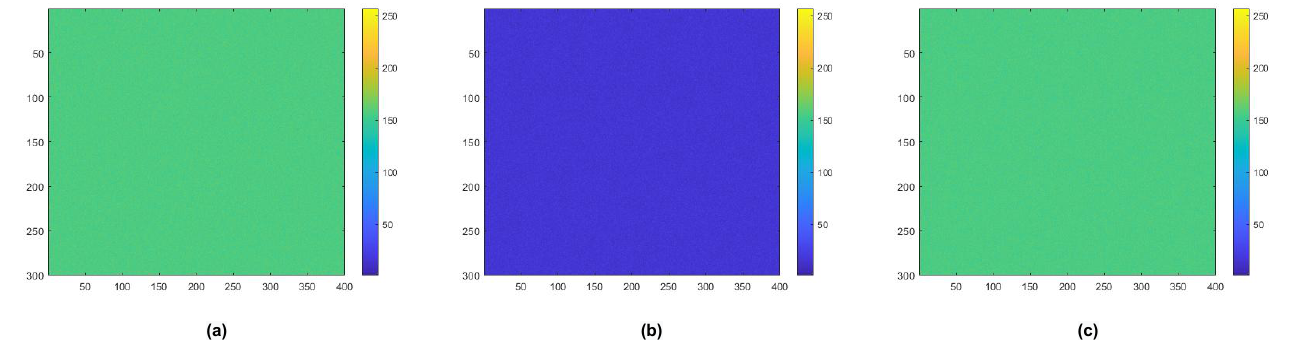
Figure 8. Image of OLED display (400 × 300) according to number of pixels. ( a ) Initial display image; ( b ) image in which luminance degradation occurred; ( c ) image when degraded luminance was